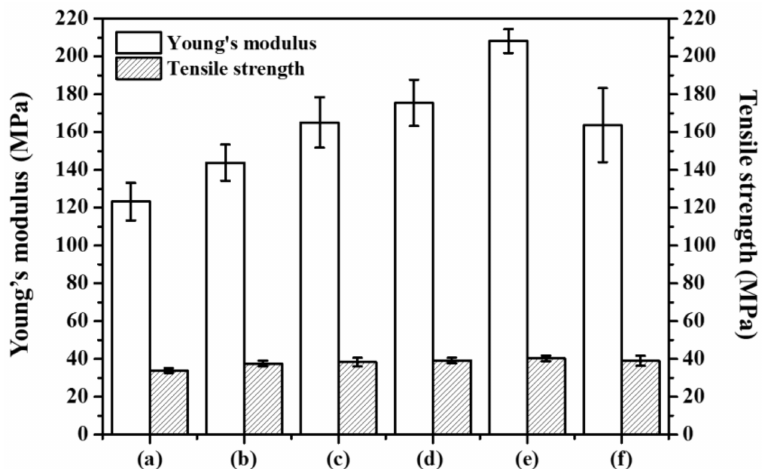
Figure 7. Mechanical properties analysis: Young’s modulus and tensile strength of ( a ) pristine PP, ( b ) 1 mass % (depending on content of CTA-Mica/PP nanocomposite), ( c ) 3 mass %, ( d ) 6 mass %, ( e ) 9 mass %, and ( f ) 12 mass